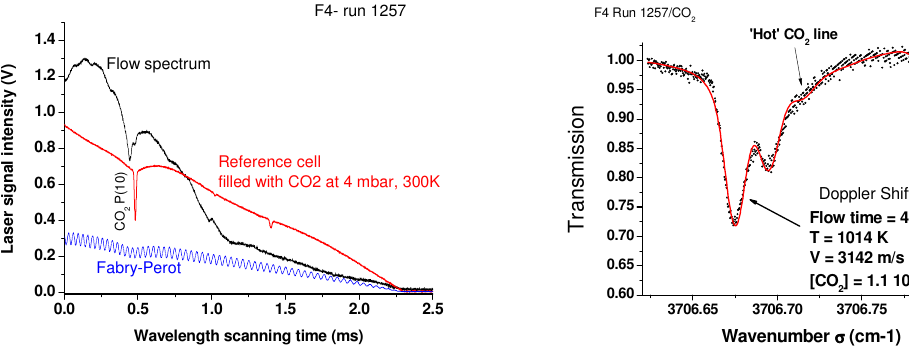
F4 run R1257 at flow time t = 43 ms.